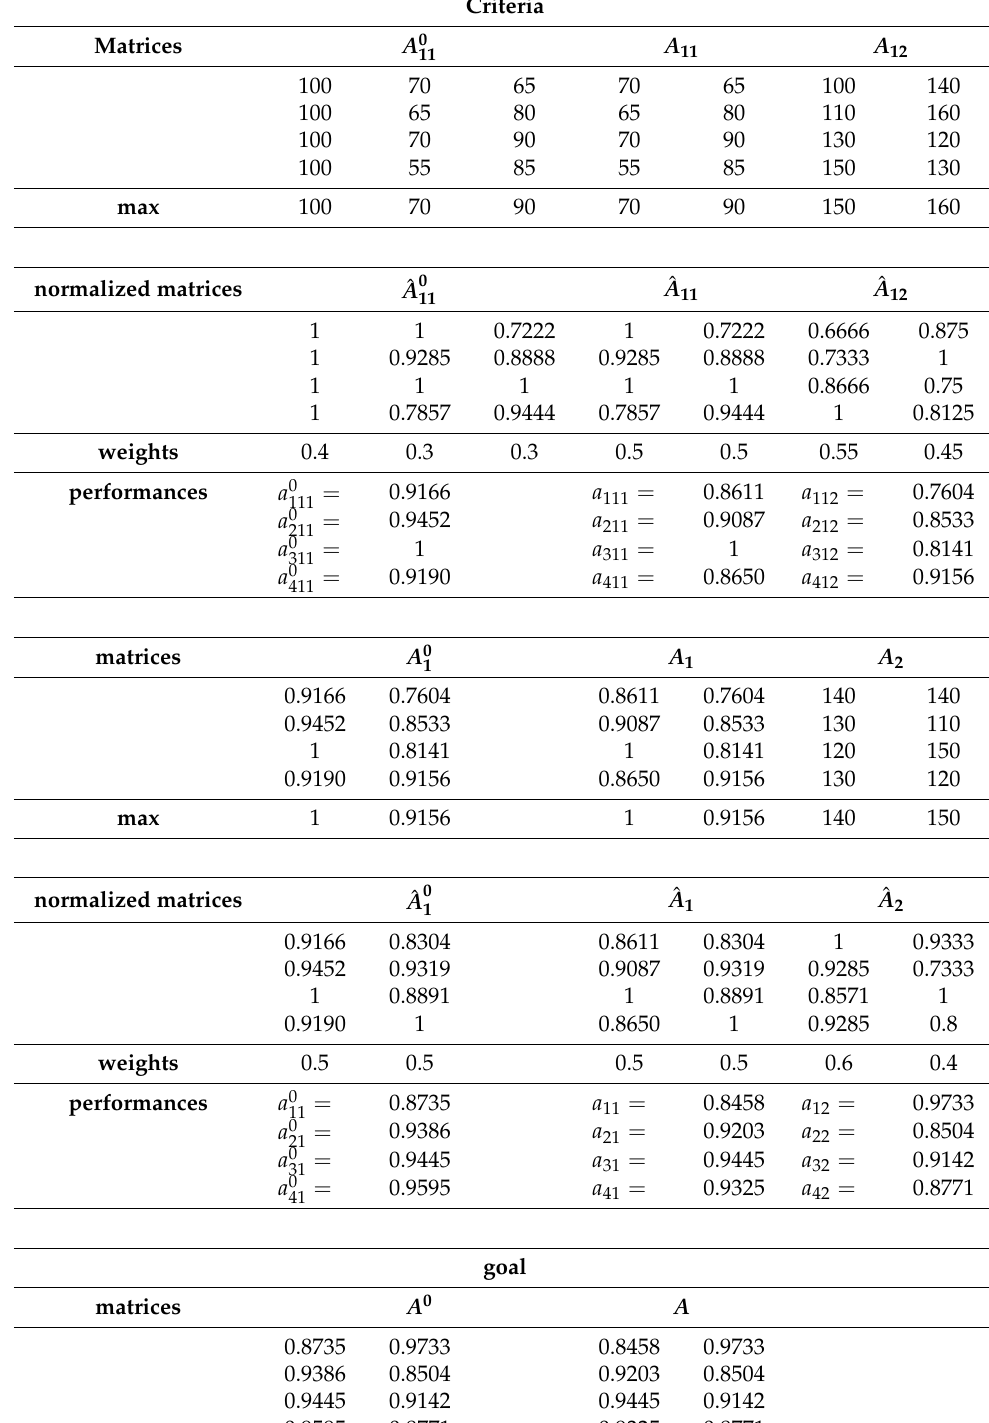
Table A3. Summary of Example 2 solution with SAW